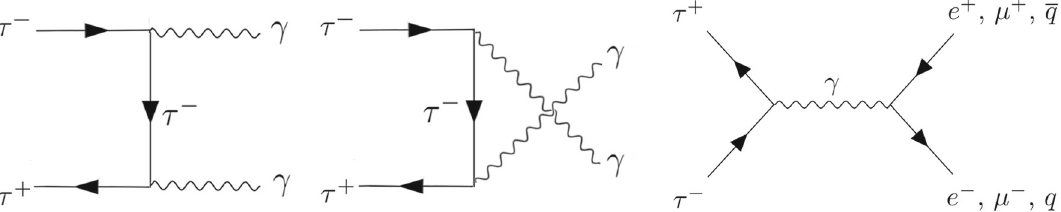
Fig. 1 LO diagrams of para- (left and center) and ortho- (right) ditauonium decays Table 1 Values of the masses of the leptons and (approximate) con- stituent quarks, tau lifetime, QED coupling, and hadronic photon vac- uum polarization self-energy for N f = 3 quark flavours, (cid:10)α